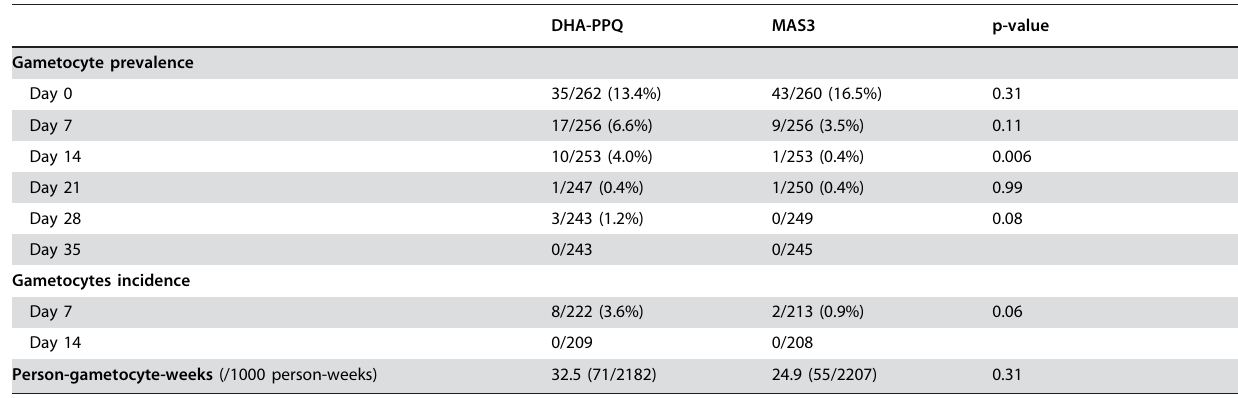
Table 3. Gametocyte prevalence and incidence by treatment group. .. ... .... ... ... .... ... ... .... ... ... .... ... ... .... ... ... .... ... ... .... ... ... .... ... ... .... ... ... .... ... ... .... ... ... .... ... ... .... ... ... .... ... ... .